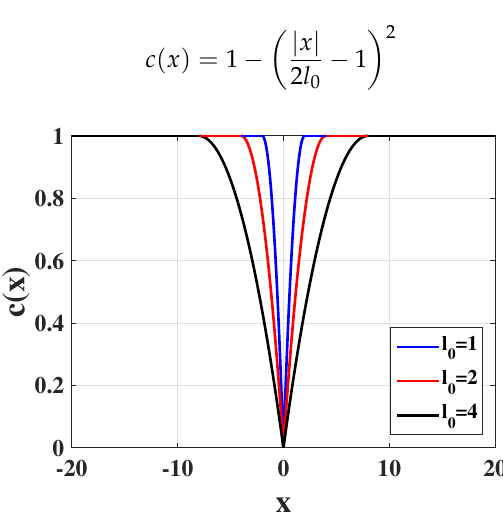
Figure 10. Second-order linear approximation: Effect of the length-scale parameter l 0 on the width of